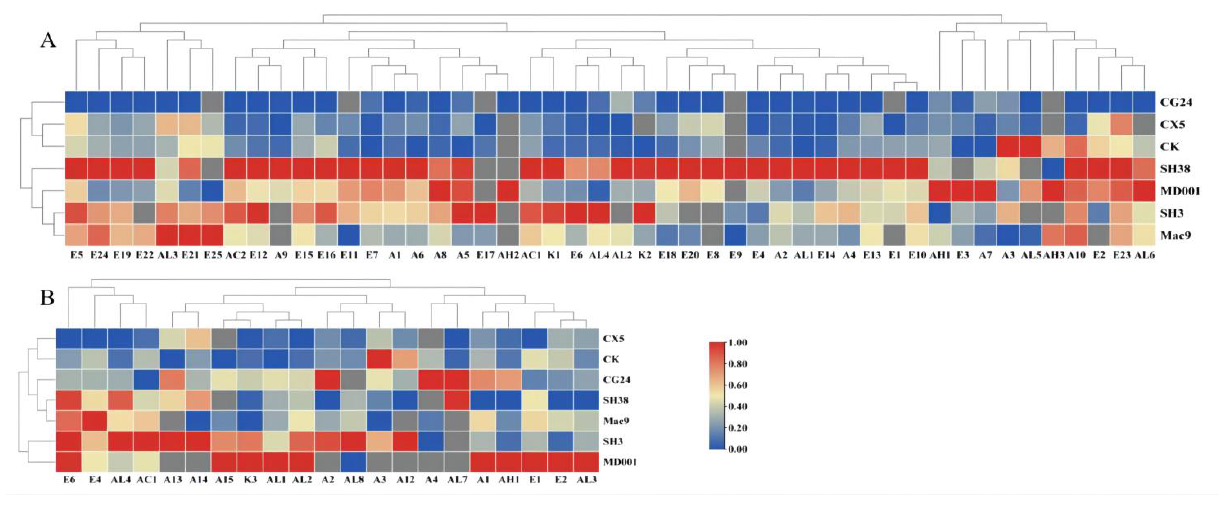
Figure 2. HCA heatmap of aroma compounds in ( A ) fruit skin and ( B ) pulp of ‘Huahong’ apples. Columns were standardized (scale method was zero to one). Color range from blue to red represents low to high aroma content, gray indicates substance was not detected.